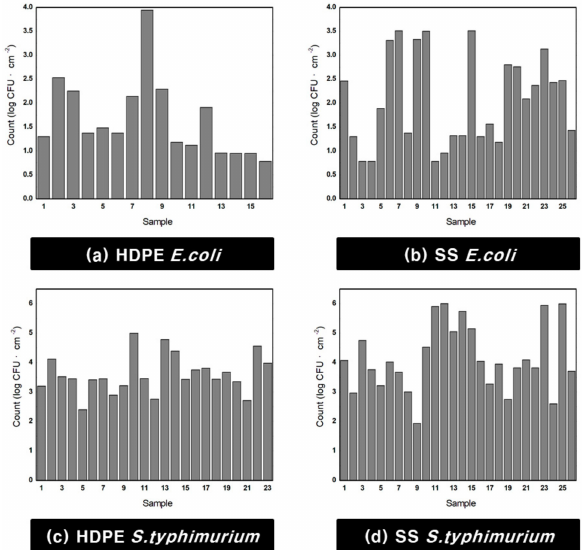
Figure 6. Cultivated E. coli and S. typhimurium count graph: ( a ) E. coli cultivated on high-density polyethylene (HDPE), ( b ) E. coli cultivated on stainless steel (SS), ( c ) S. typhimurium cultivated on HDPE, and ( d ) S. typhimurium cultivated on SS.